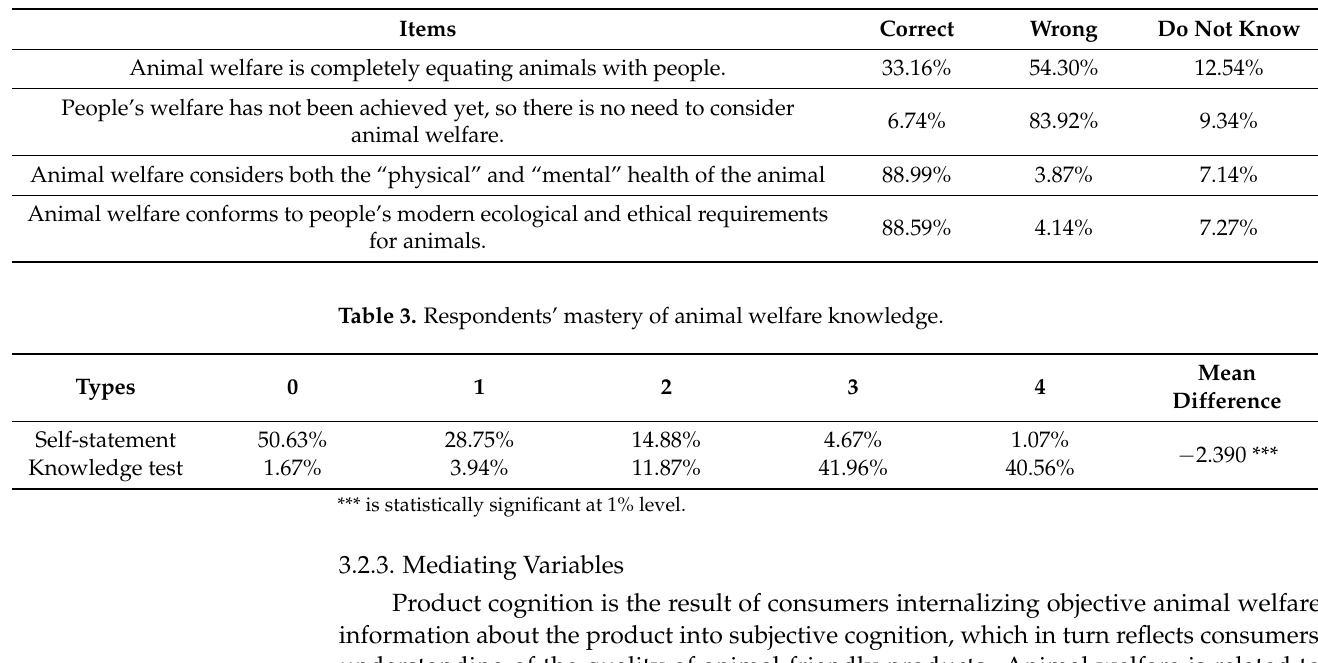
Table 2. Answers to questions related to animal welfare knowledge.